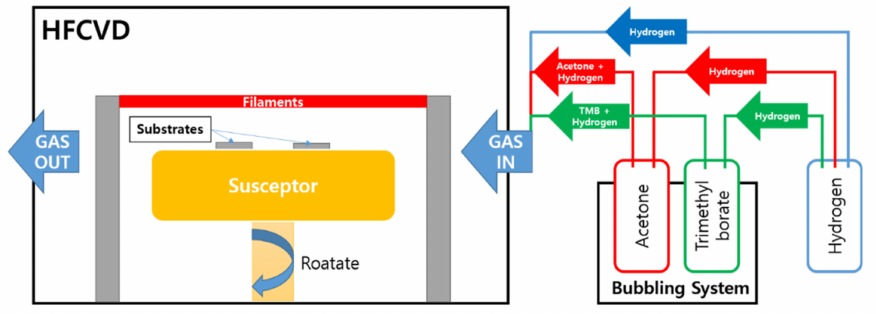
Figure 1. Schematic diagram of hot-filament chemical vapor deposition (HFCVD) and bubbling